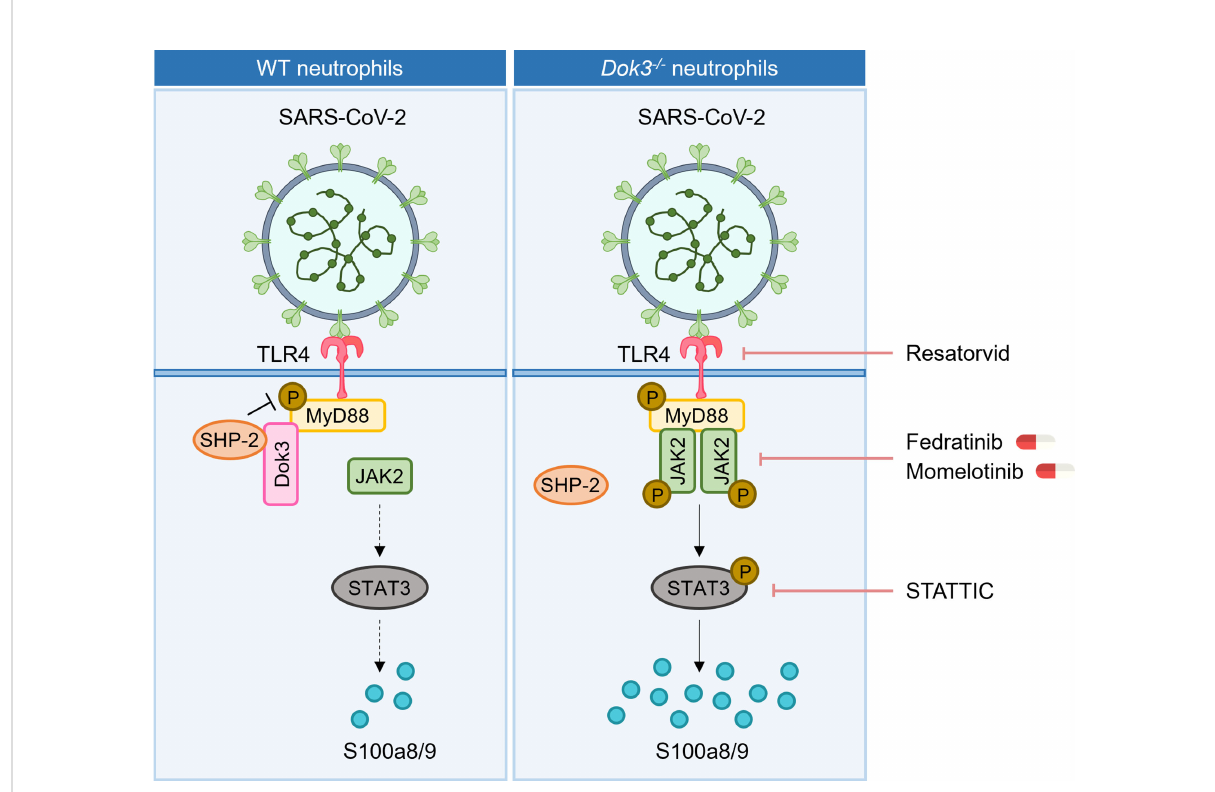
FIGURE 6 Proposed signaling mechanism underlying Dok3 negative regulation of calprotectin production in neutrophils. Binding of the SARS-CoV-2 S protein to TLR4 triggers phosphorylation of MyD88 on Y257. This activates downstream JAK2-STAT3 signaling cascade to turn on the production of calprotectin. Dok3 negatively regulates this pathway by recruiting SHP-2 to mediate the de-phosphorylation of MyD88, as such preventing excessive release of calprotectin which leads to uncontrolled in fl ammation associated with severe COVID-19. Treatment with TLR4 inhibitor Resatorvid and STAT3 inhibitor STATTIC, as well as clinically approved JAK inhibitors Fedratinib and Momelotinib, can dampen calprotectin production by neutrophils, revealing potential therapeutic targets to improve disease outcome in severe COVID-19